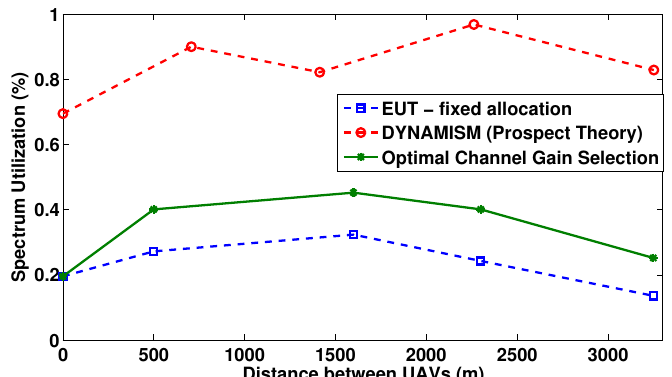
Figure 6. Average total spectrum utilization for increasing distance between the UAVs under different resource management